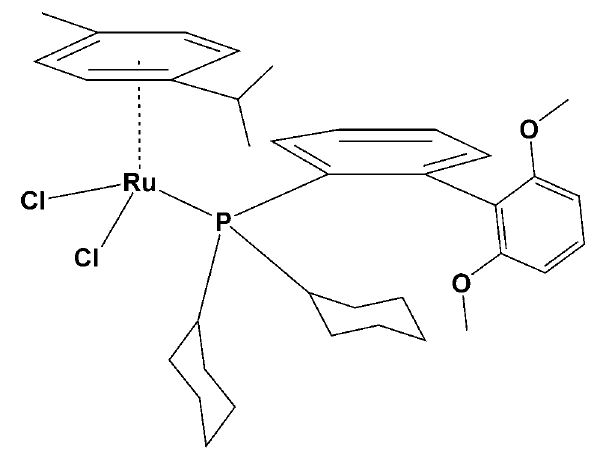
Table 1 Hydrogen-bond geometry (A˚ , (cid:3)